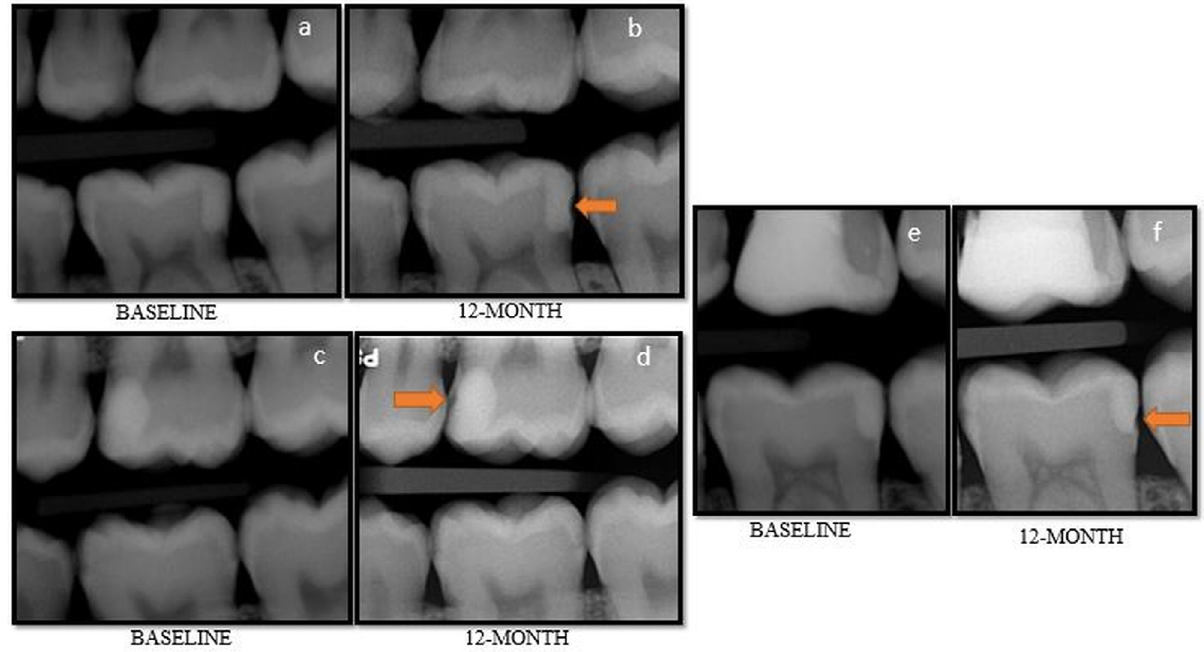
Figure 5- Glass ionomer material loss that could be radiographically seen in the proximal area as a result of dissolution